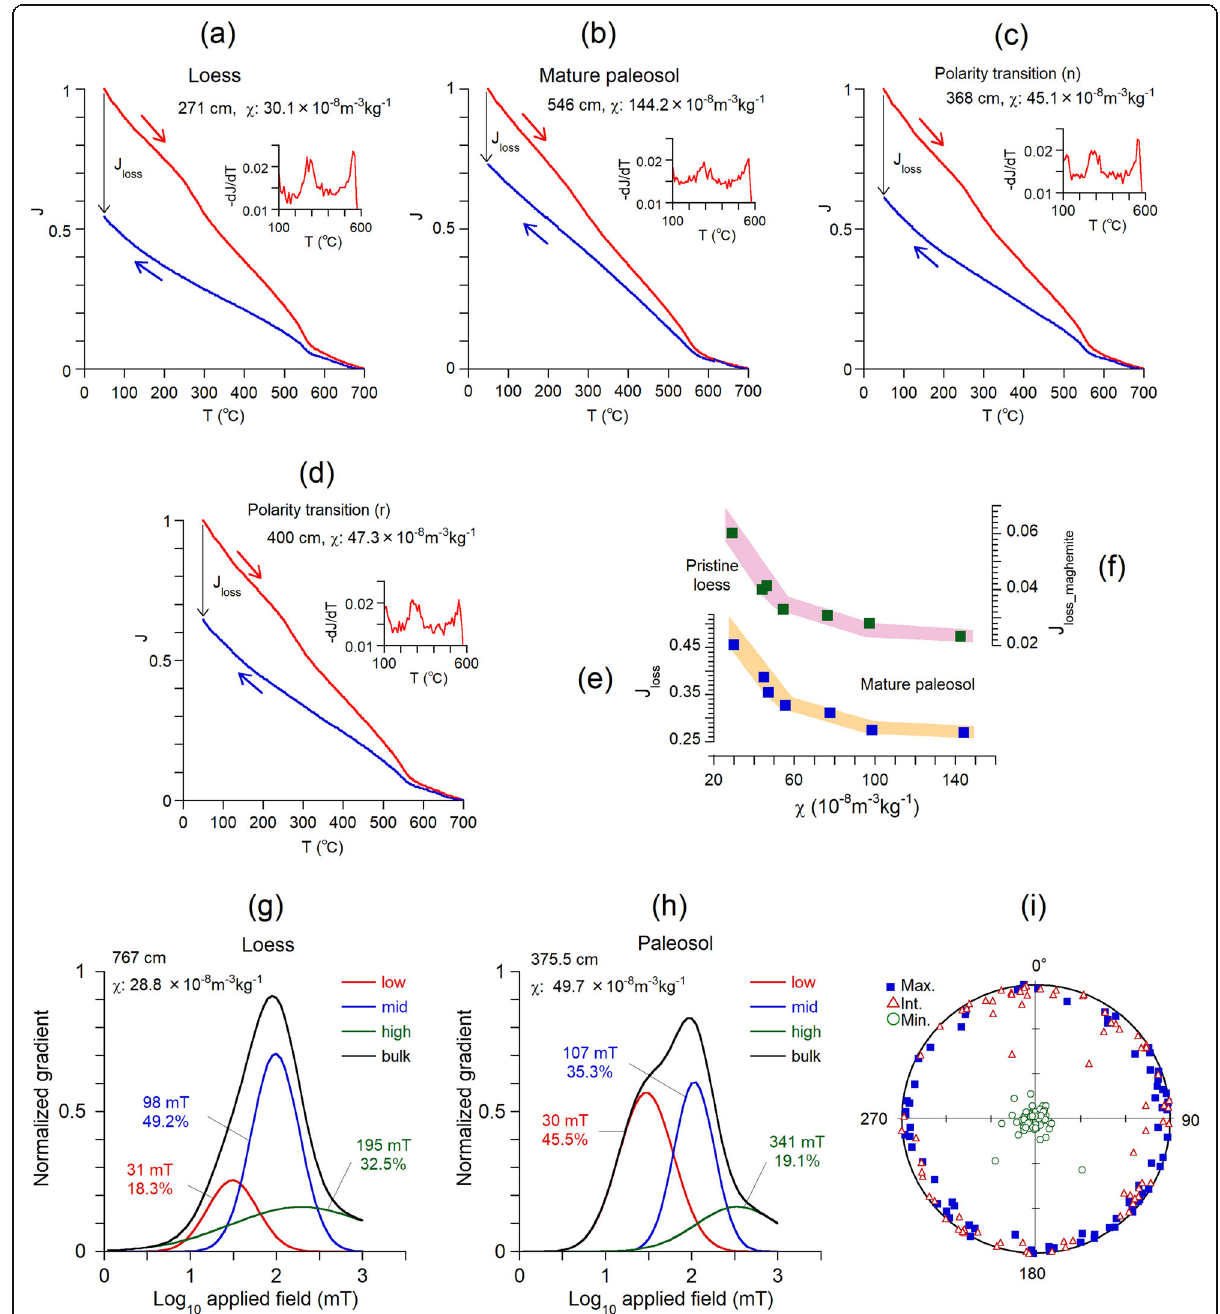
Fig. 1 Results of rock magnetic experiments and anisotropy of magnetic susceptibility measurements. a – d Temperature dependence of magnetization normalized by an initial value ( J ). The red/blue curves show heating/cooling. – dJ/dT indicates the first derivative of J – T heating curves calculated at intervals of 10 °C. e The loss of total magnetization versus magnetic susceptibility ( χ ). f The magnetization loss by maghemite decomposition versus χ , calculated as a sum of the first derivatives of the J – T curves between 240 and 340 °C subtracted by the background magnetization decrease of magnetite, a mean of the first derivatives between 140 and 240 °C. g , h Results of isothermal remanent magnetization component analysis for loess and paleosol. i Anisotropy of magnetic susceptibility. The blue solid square/red open triangle/green open circle symbols represent the maximum/intermediate/minimum axes of magnetic susceptibility,